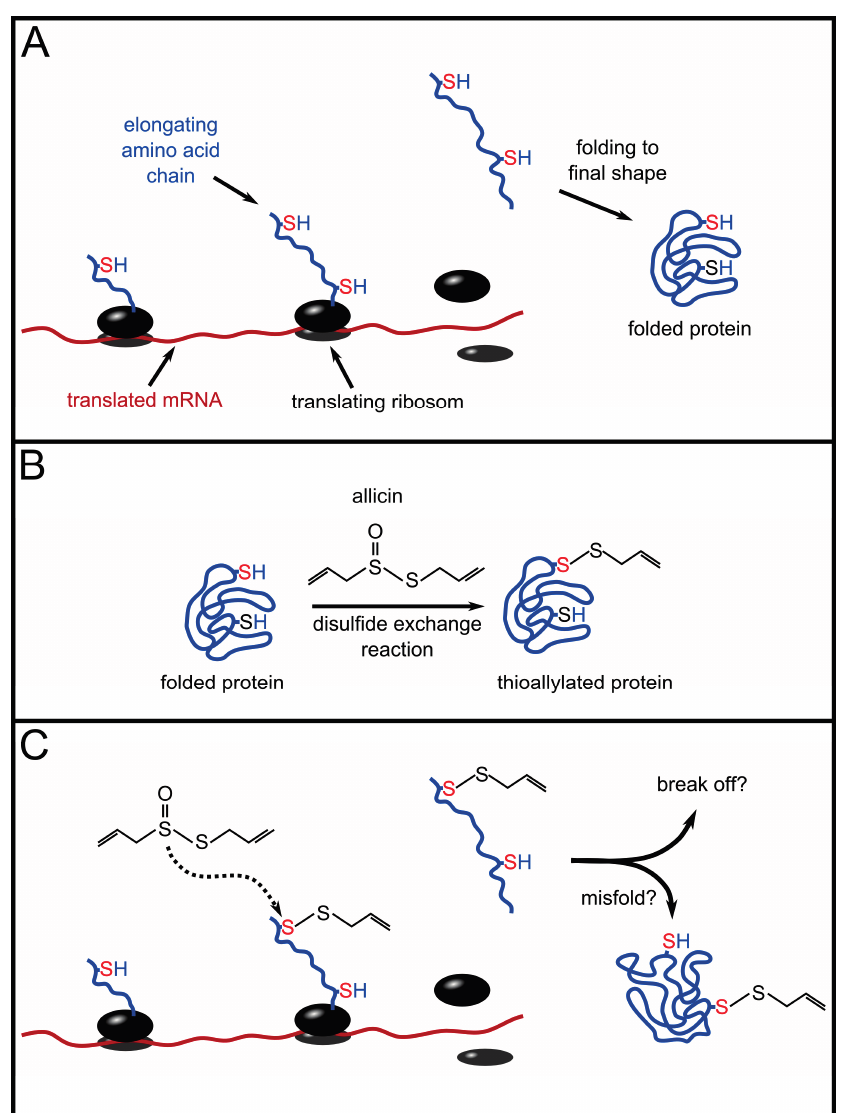
Figure 2. Possible influence of allicin on proteins and protein synthesis. ( A ) protein synthesis in unstressed conditions. After translation the protein is folded into its final structure. ( B ) The cysteine residue that is accessible for attack (indicated in red) reacts with allicin via a disulfide exchange-reaction. The cysteine residue that is sterically blocked (indicated in blue) does not react with allicin. ( C ) According to Cavallito’s hypothesis, allicin may attack cysteine residues on elongating amino acid chains while the protein is still being synthesized and is not fully developed [48]. In this early stage, cysteine residues that are normally blocked for reactions with allicin (compare B) are now potential targets. Possible results may be an abortion of translation or misfolded proteins with reduced or no